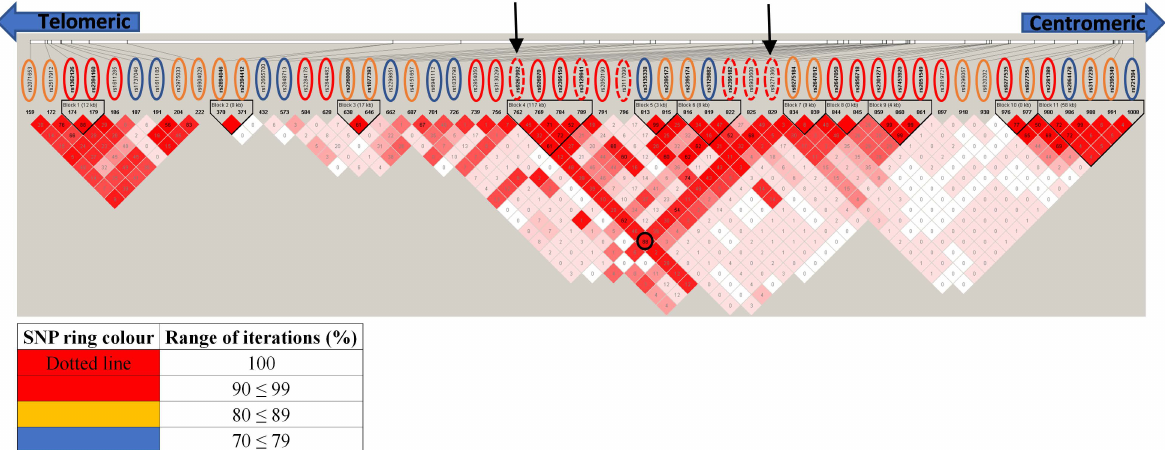
Figure 3. Haplotype structure of the HLA SNPs identified by the elastic net model (Table 2) using haploview. The rsIDs are given at the top of the display, with the coloured rings representing the following range of iterations they were selected by the elastic net model: blue (70 ≤ 79%), orange (80 ≤ 89%), red (90 ≤ 99%) and red dotted (100%). For each SNP, their corresponding r 2 value are given within each diamond (shown as 0–100, which is equivalent to 0.00–1.0) and red shading indicating strength of D’ between SNPs intersecting diagonally (see Figure S1 for the individual r 2 and D’ plots). As expected, there is a complex underlying LD structure across the HLA region with 11 blocks of inherited SNPs predicted by haploview, consisting of 2–5 SNPs each. Of the 12 SNPs that were identified above 98% iterations from elastic net analysis, only rs9267992 and rs9271366 (black arrows meeting at the black circle) were determined to be in strong LD and co-inherited (r 2 ≥ 0.7 and D’ ≥ 0.8). These two SNPs also flank a central set of SNPs (encompassing blocks 4, 5 and 6), both with a relatively high level of LD for all SNPs located between them (see supplemental notes for additional